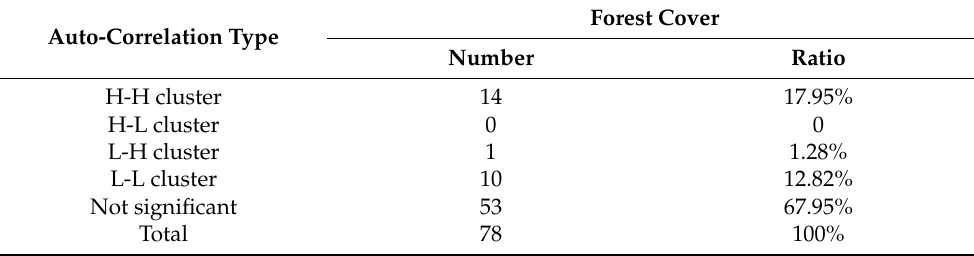
Table 3. Summary of local spatial auto-correlation categories and the number of districts and counties with forest cover in Fujian